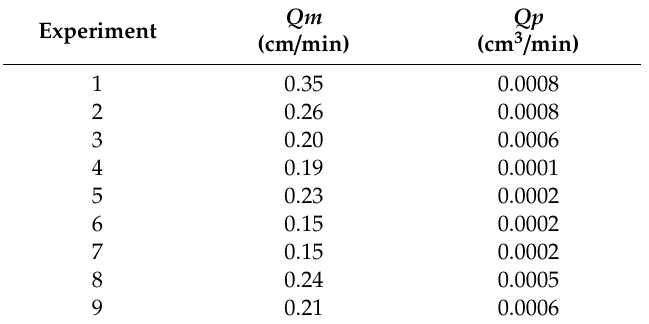
Table 3. Material removal rate and tool wear results (average value of each